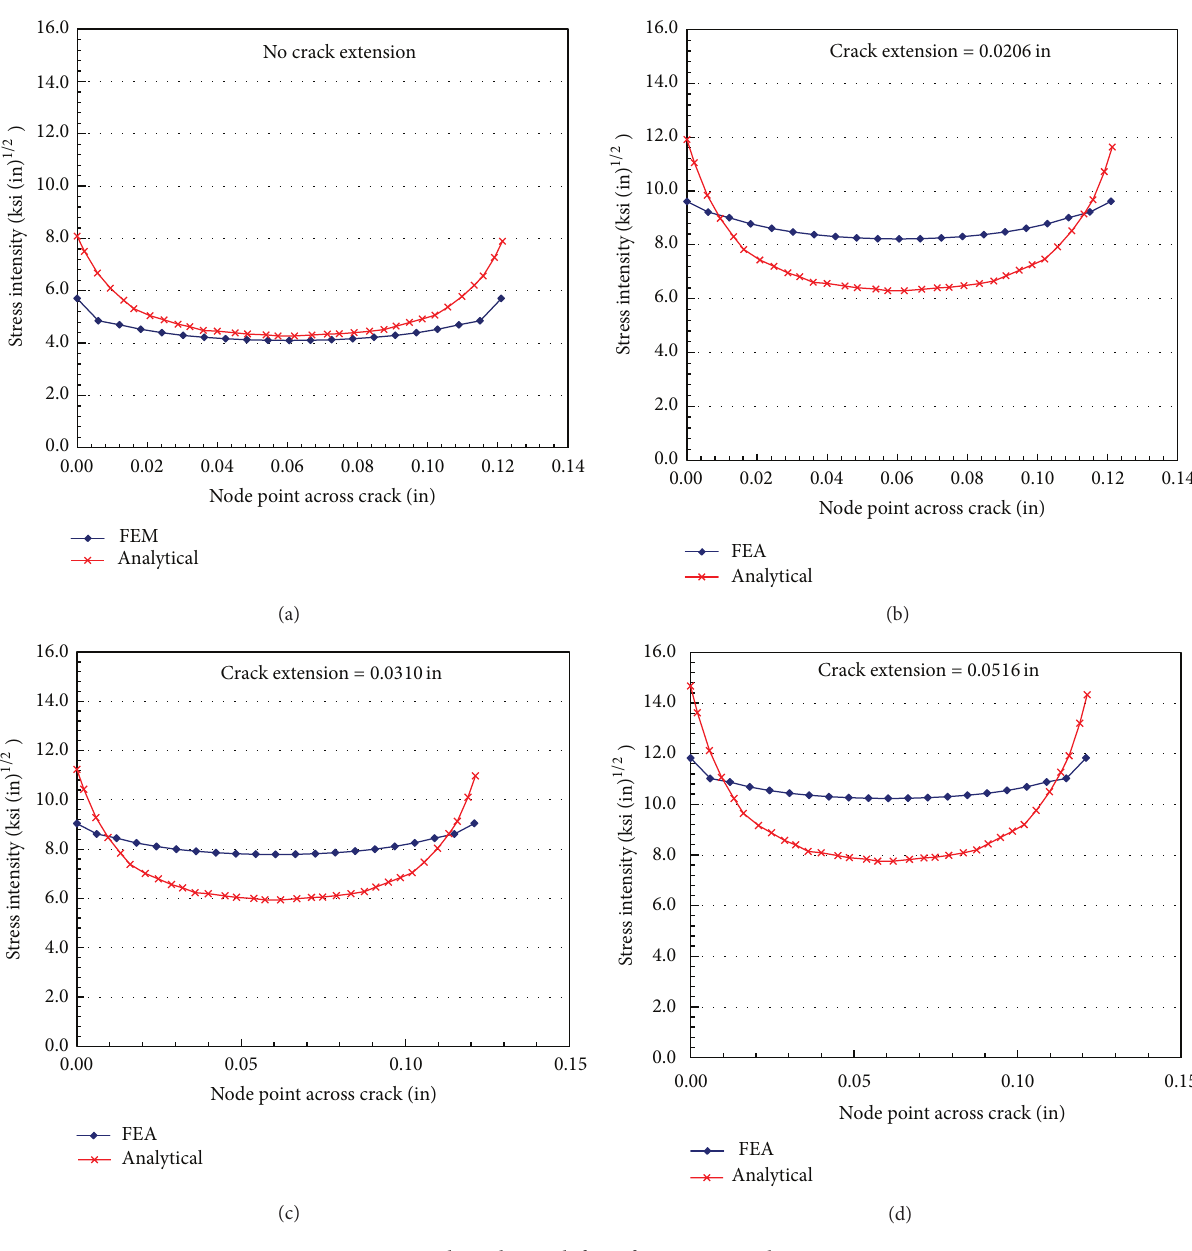
Figure 14: 𝐾 𝐼 along the crack front for various crack